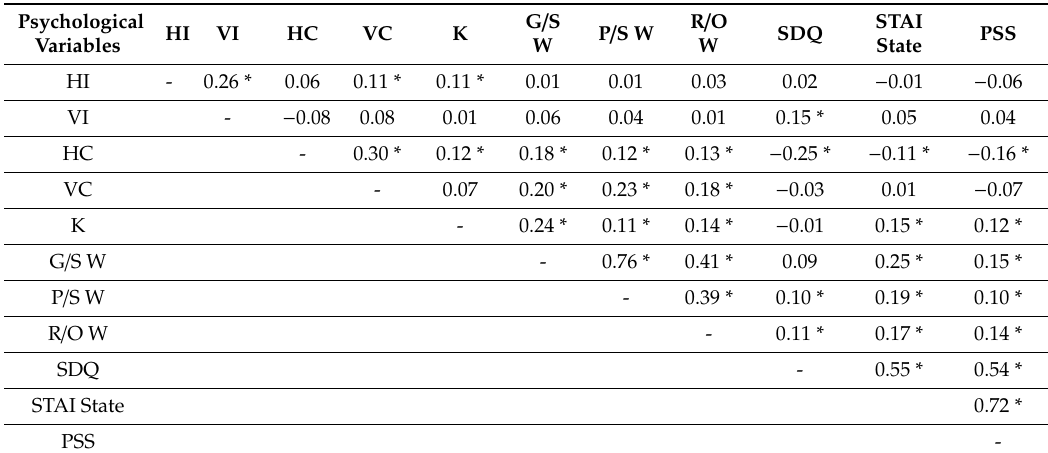
Table 3. Bivariate correlations of INDCOL, knowledge, worries and concerns about COVID-19, emotional and behavioral di ffi culties, state anxiety, and stress. Psychological